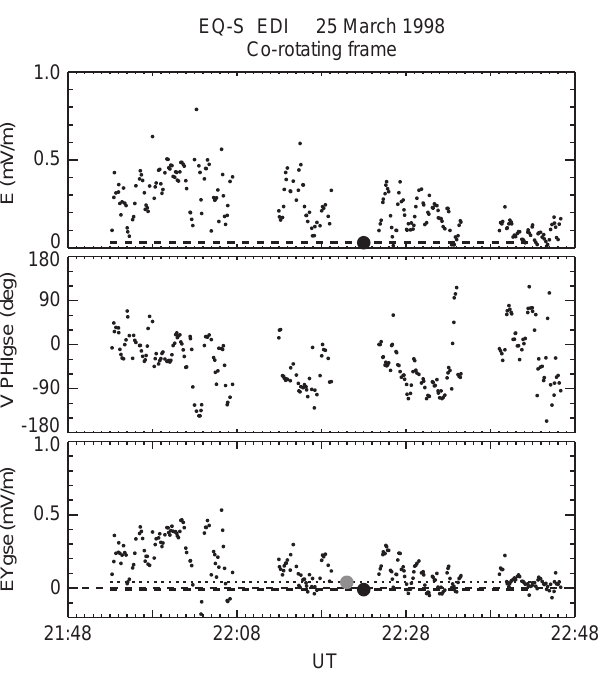
Fig. 8. April 6, 1998 measurements in the co-rotating frame. Same format as Fig. 5. Missing data (01:45–01:49 and 01:56–02:02) are gaps in EDI triangulation telemetry during diagnostic testing